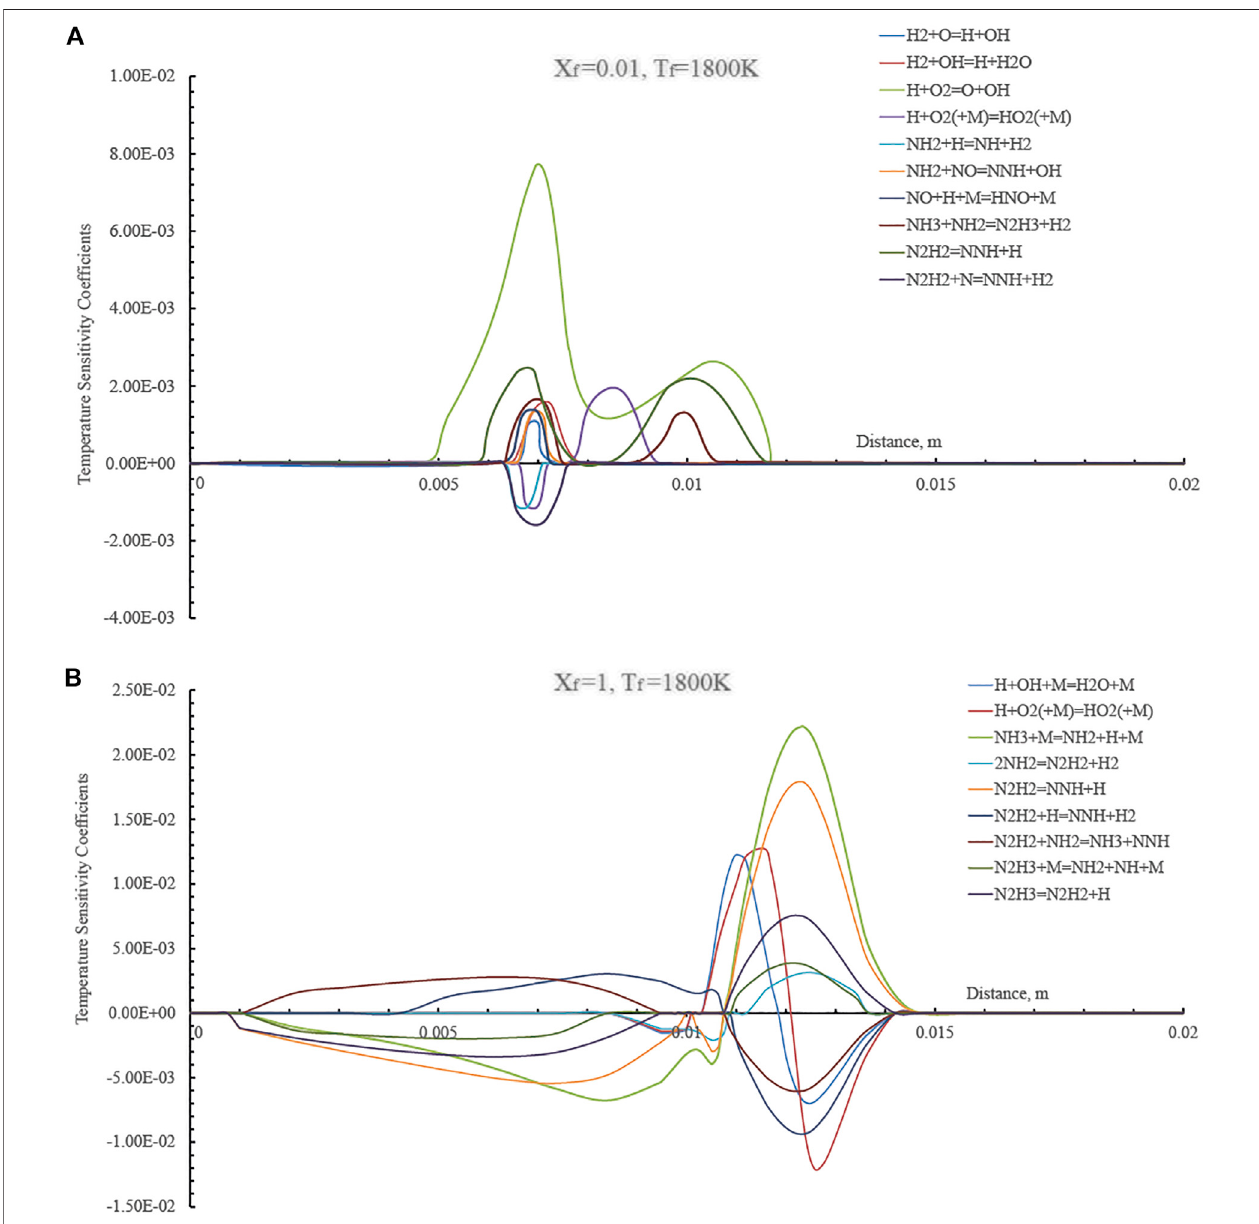
FIGURE6| Temperature sensitivity coef fi cients as a function of the axial distance in the HFDF con fi guration for T 0 (cid:1) 1,800 K, Xf (cid:1) 0.01 (A) and Xf (cid:1) 1 (B) , K 0 (cid:1) 50 s − 1 , P (cid:1) 1